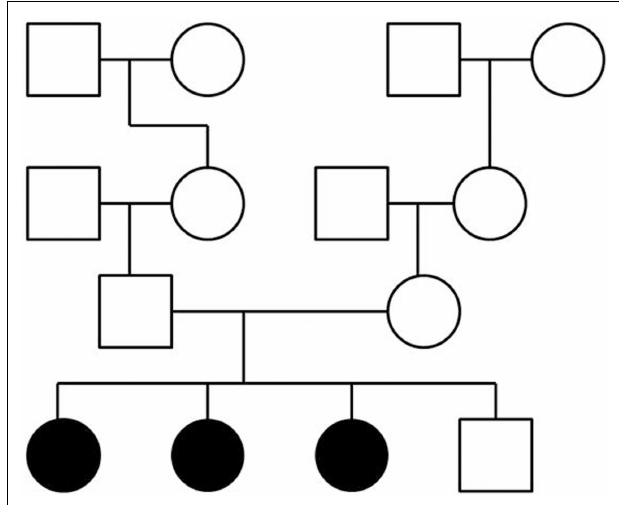
FIGURE 1 | Pedigree of a family with three siblings diagnosed with bipolar disorder and co-morbid anxiety spectrum disorders .The three-generation pedigree did not indicate additional psychiatric disorders on the father’s side or the mother’s side of the family. In this pedigree, a circle indicates a female, a square indicates a male. A filled symbol indicates a person affected with bipolar disorder and co-morbid anxiety spectrum disorders. An unfilled symbol indicates a healthy individual. Family relationships are indicated by